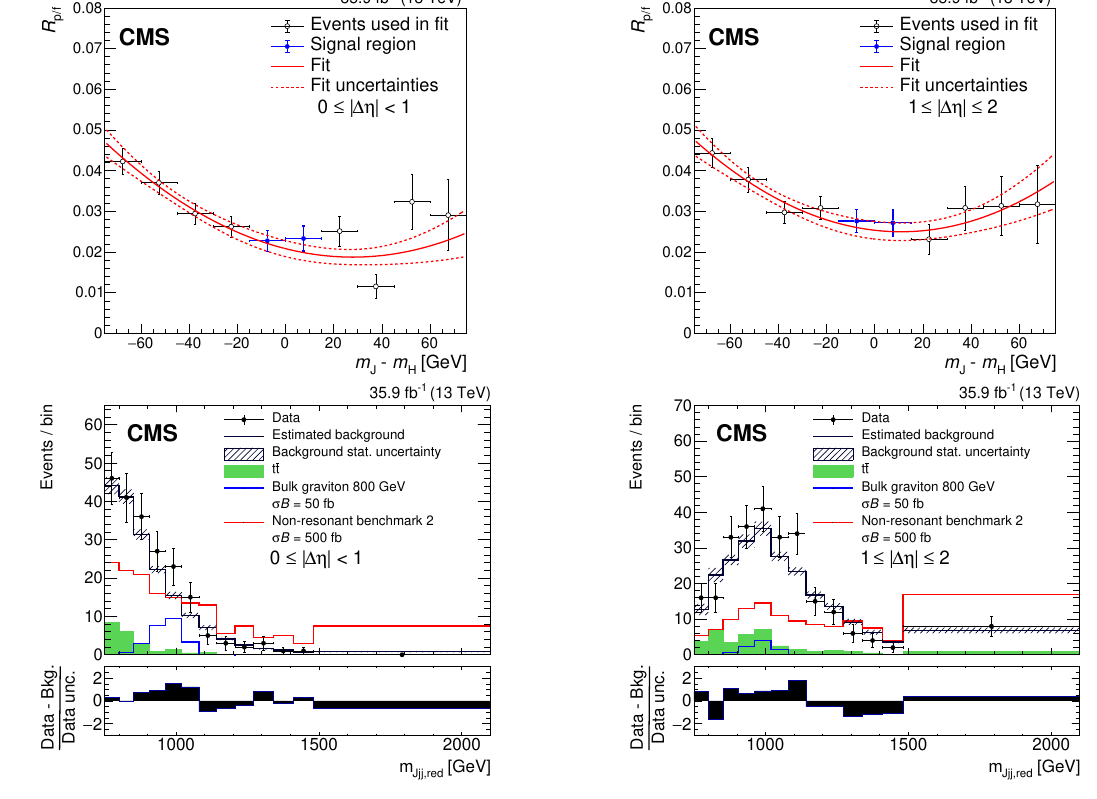
Figure 4 . Upper: the double-b tagger pass-fail ratio R of the leading- p T AK8 jet in semi- p/f resolved events as a function of the di(cid:11)erence between the soft-drop mass and the Higgs boson mass, m J (cid:0) m H . The measured ratio in di(cid:11)erent bins of m J (cid:0) m H is used in the (cid:12)t (red solid line), except in the region around m J (cid:0) m H = 0, which corresponds to the signal region (blue markers). The (cid:12)tted function is interpolated to obtain R in the signal region. Lower: the reduced mass p/f distribution m Jjj,red in the data (black markers) with the estimated background represented as the black histogram. The tt+jets contribution from simulation is represented in green. The rest of the background is multijets, calculated by applying the R to the antitag region. The uncertainty p/f in the total background, before (cid:12)tting the background model to the data, is depicted using the shaded region. The signal distributions for a bulk graviton with a mass of 800 GeV (blue) and the non-resonant benchmark 2 model (red) are also shown for assumed values of the products of the production cross sections for HH and the branching fraction to 4b, (cid:27) B . For the left and right (cid:12)gures, the pseudorapidity intervals are 0 (cid:20) j (cid:1) (cid:17) j < 1 and 1 (cid:20) j (cid:1) (cid:17) j (cid:20) 2,